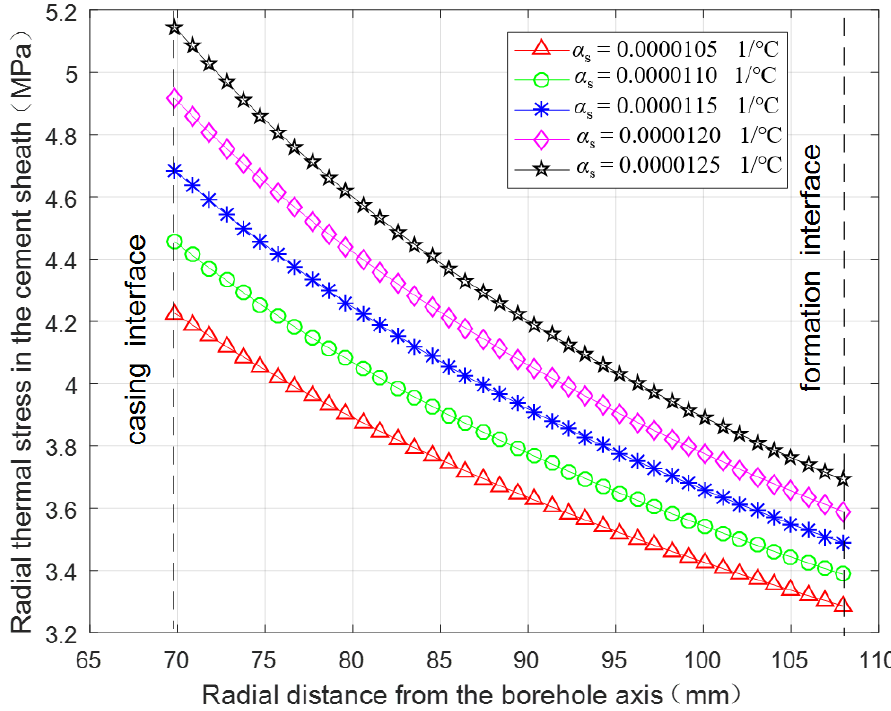
Figure 7. Radial distribution of the radial thermal stress in the cement sheath under different linear thermal expansion coefficients of the casing.